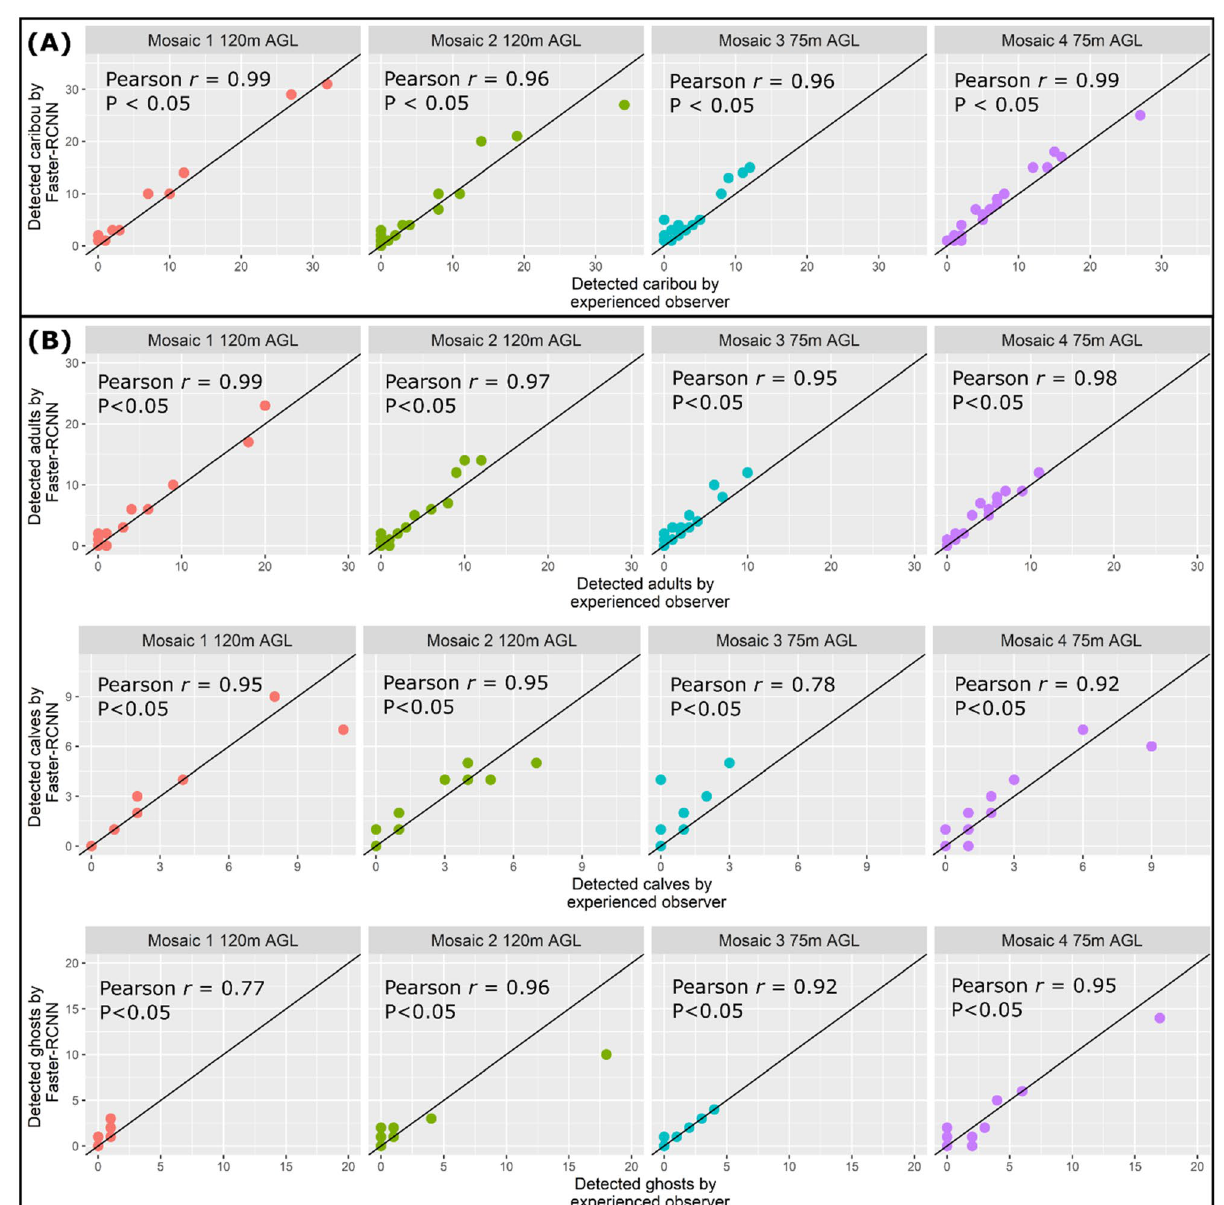
Figure 4. Comparison between ( A ) the individual caribou counts and ( B ) caribou adults, calves, and ghosts of the experienced observer and the Faster-RCNN per tile for each mosaic. The diagonal 1:1 line indicates a perfect fit of the experienced observer and Faster-RCNN counts. Plots were created using R v 4.1.3 (R Core Team, 2022) and figure assembled using Affinity Designer v 1.9.1.979 (https:// affin ity. serif.